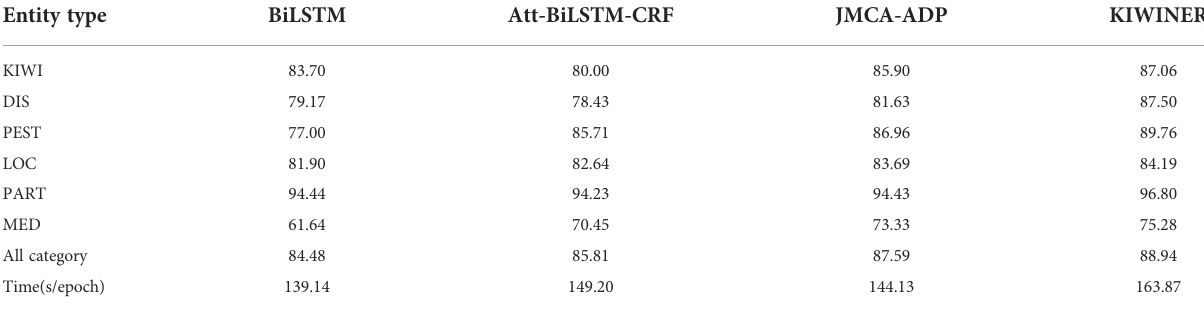
TABLE 8 Entity categories